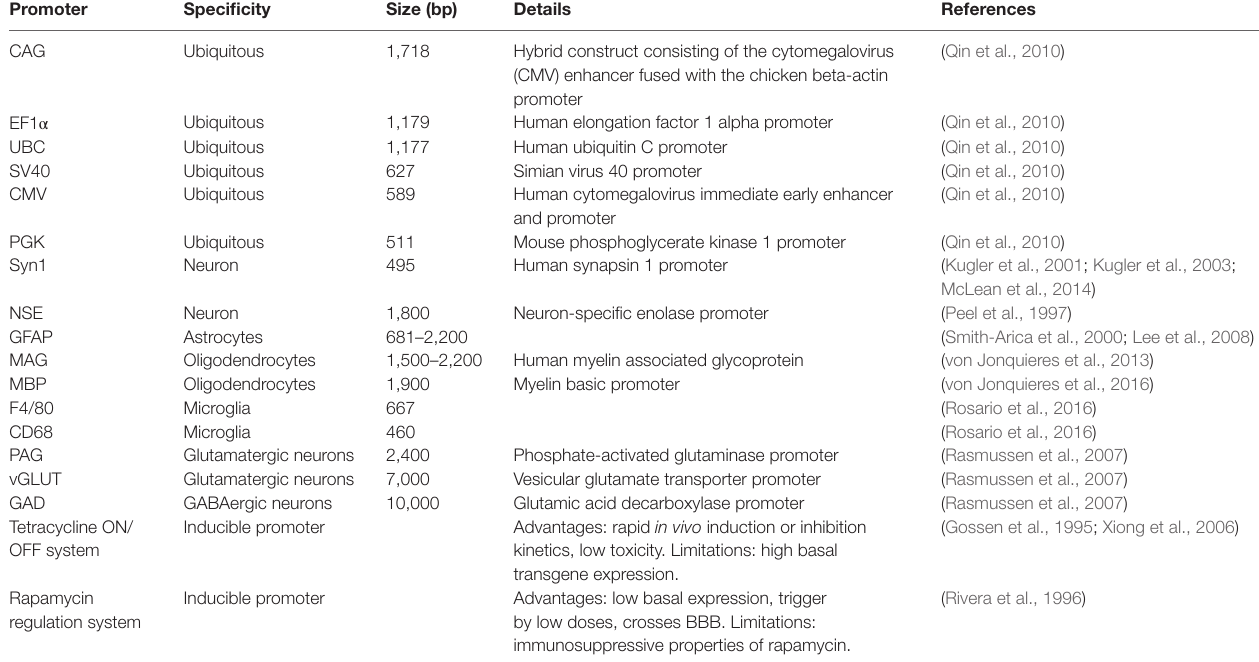
TABLE 2 | Regulation of gene expression at transcriptional